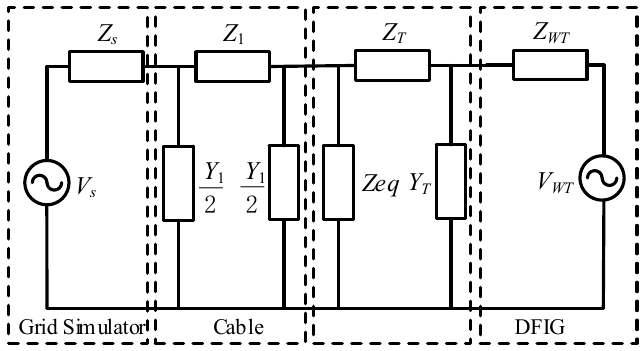
Figure 10. Equivalent circuit of HA testing system of the selected harmonic frequency.